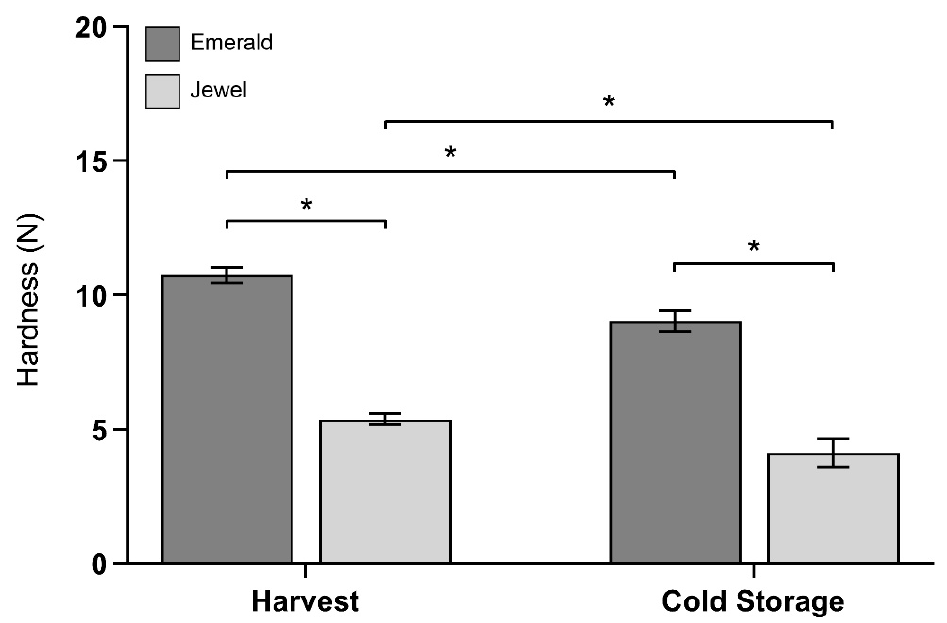
Figure 1. Firmness (as hardness) of two selected blueberry cultivars “Emerald” and “Jewel” at harvest stage and after 30 d of cold storage. Error bars represent SEM (n = 10). Data were analyzed by t -test (* p < 0.05).